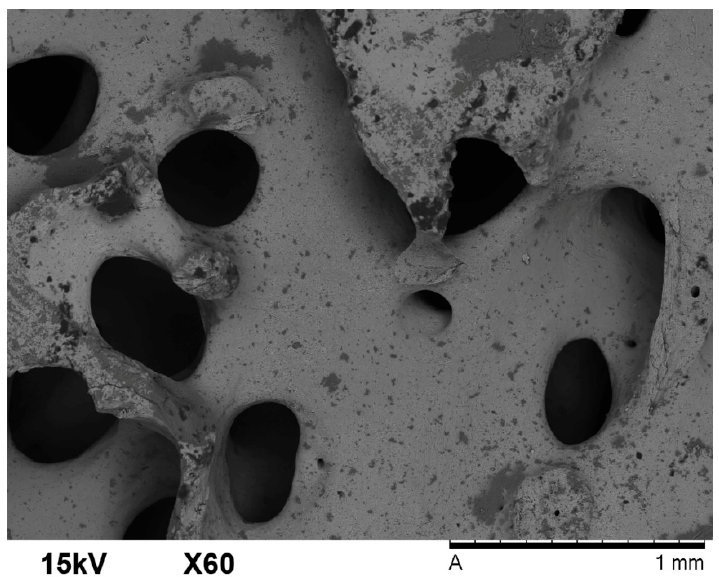
Figure A1. Scanning electron microscopy cross section of inorganic xenogenous bone (control group) showing the morphology and interconnectivity of the pores. Magnification 60×.